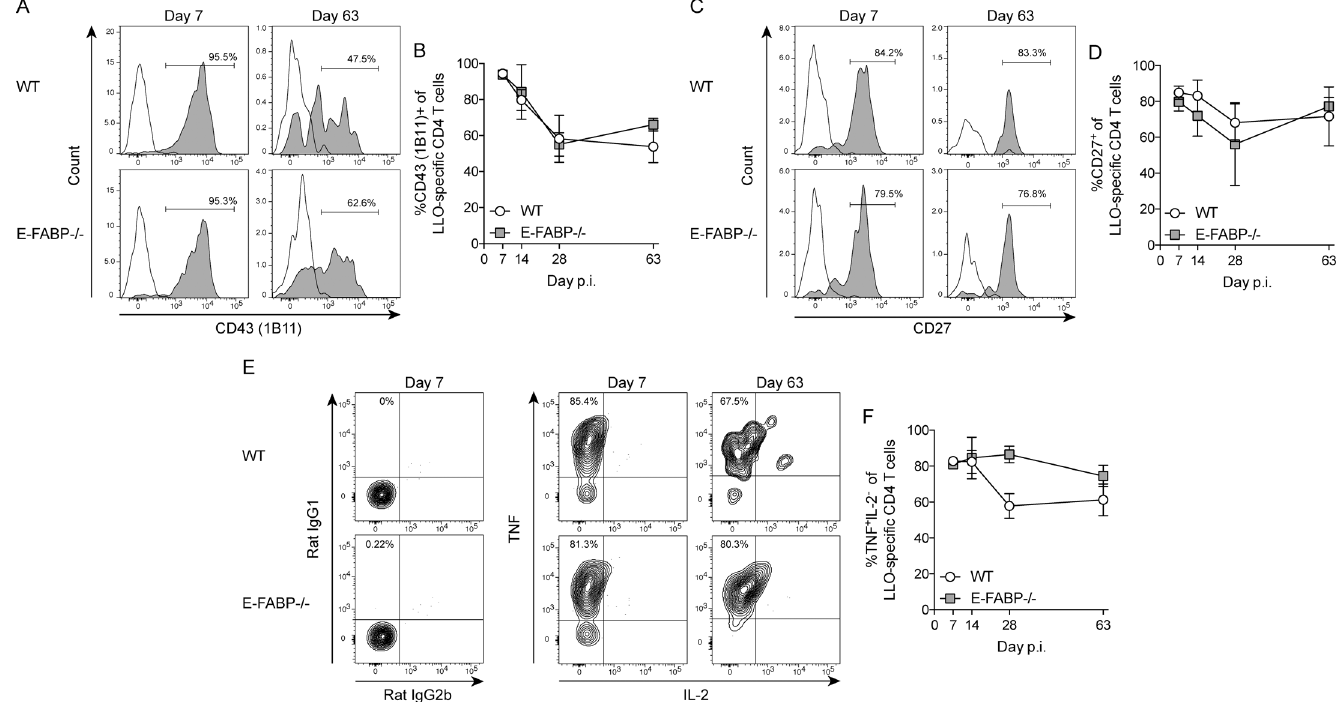
Fig 4. Phenotypic and functional characterization of Listeria -specific CD4 T cells. (A, C, E) Representative histograms and contour plots from day 7 or day 63 showing the frequency of LLO-specific CD4 T cells that are positive for the indicated cell surface marker or cytokine. (A) Open histogram is isotype control; gray histogram is CD43 (clone 1B11). (C) Open histogram is isotype control; gray histogram is CD27. (B, D, F) Total percentage of LLO- specific CD4 T cells positive for the indicated cell surface marker or cytokine on the indicated days. Data (mean ± s.d.) are from 3-mice/time point/group except day 63 WT (n = 2). Data are representative of two independent experiments and were analyzed by the Mann-Whitney test.